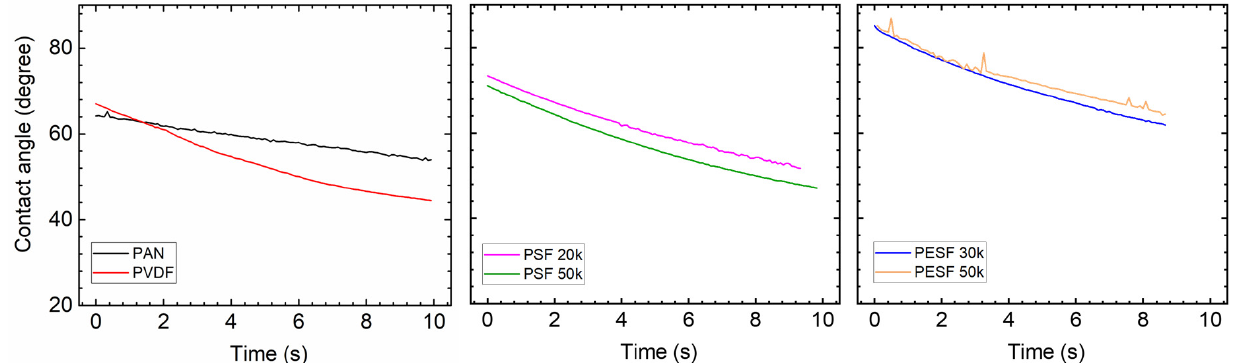
Figure 13. Contact angle of di ff erent porous support coated with PVA